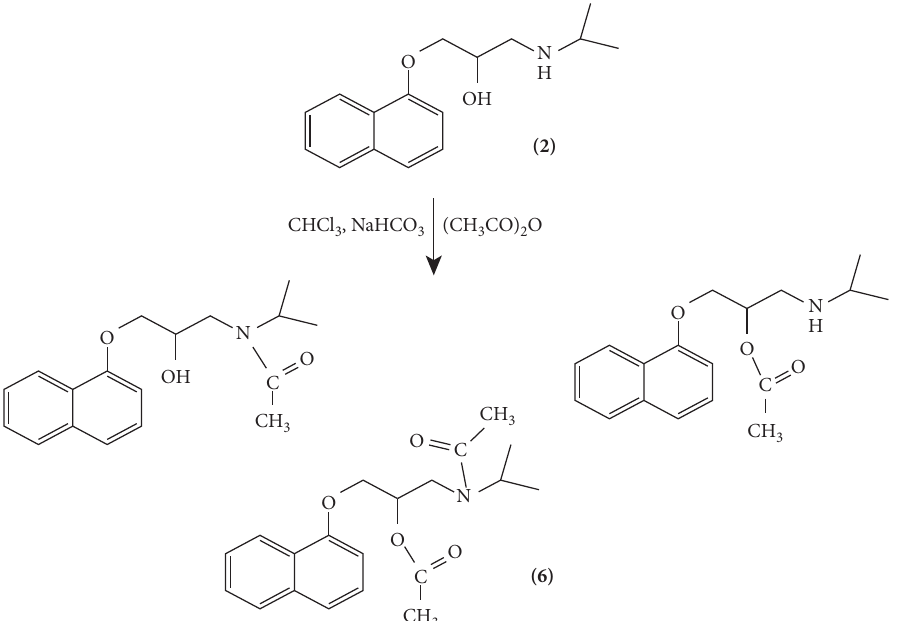
Figure 4: The scheme describes the synthesis of propranolol with anhydride acetic at conditions of CHCl